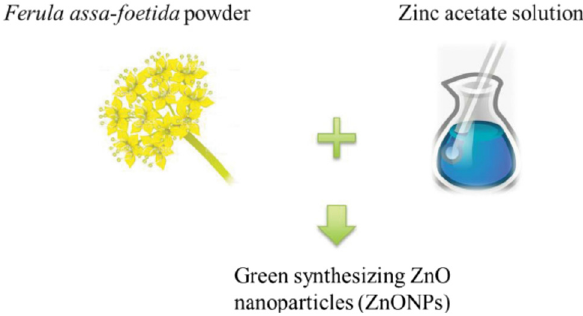
Figure 15: Green synthesis of ZnO NPs uses Ferula Assa - foetida [ 69 ] . Copyright © 2021;